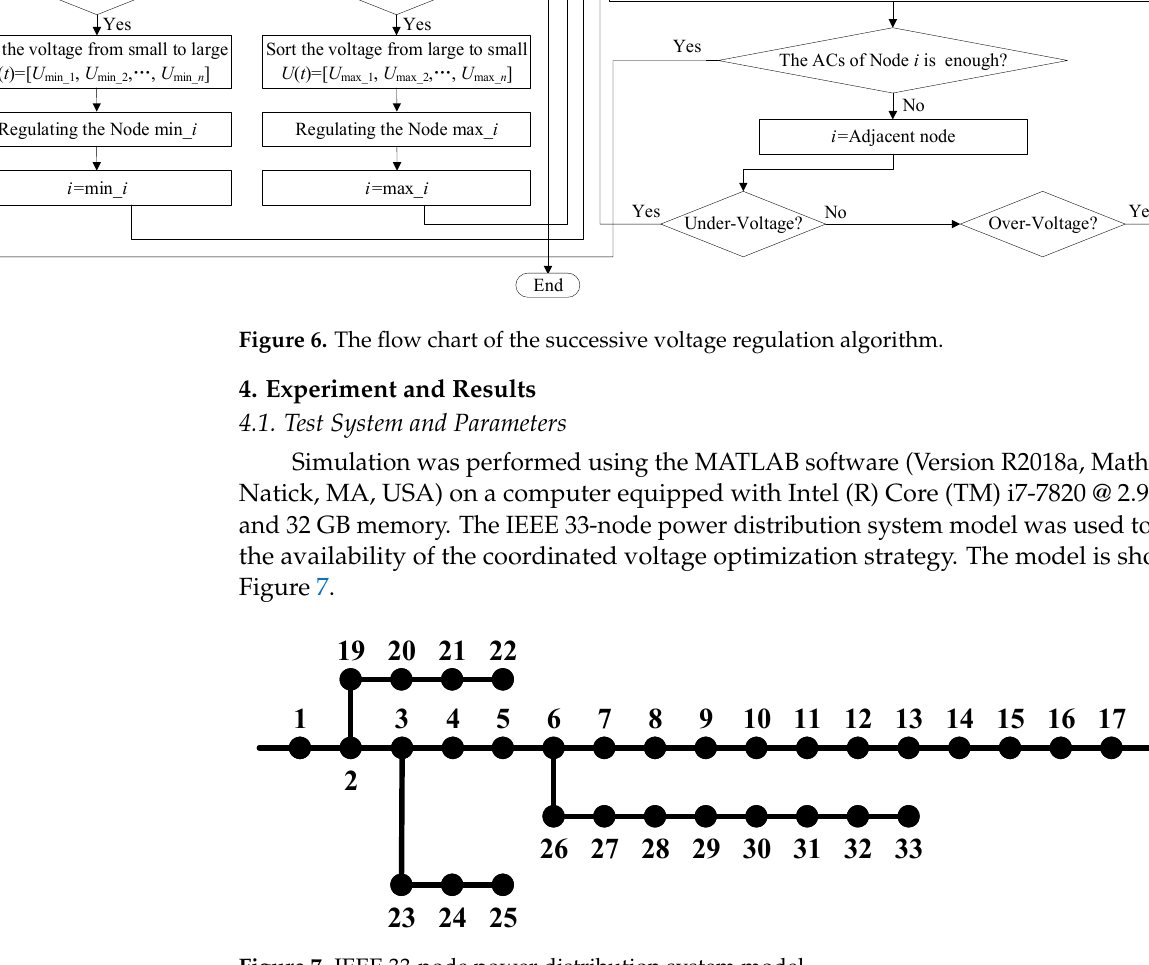
Figure 7. IEEE 33-node power distribution system model.